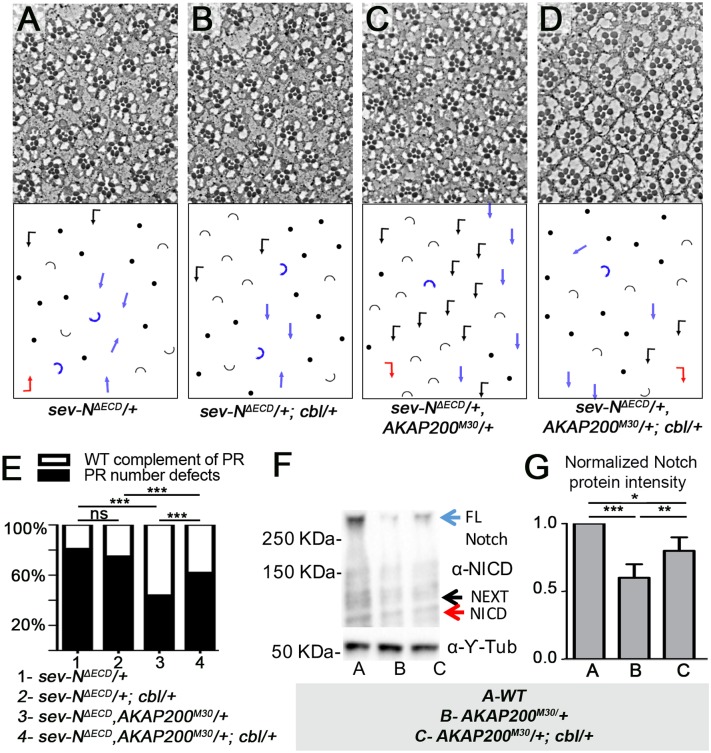
The effect of AKAP200 on Notch signaling depends on Cbl.(A-D) Tangential adult eye sections of indicated genotypes, with schematics in lower panels (see
Fig 2A
for key). (A) PR number defects induced by sev-NΔECD are not modified by the heterozygous cbl mutant alone (B), but are suppressed by heterozygous AKAP200 mutant (C). (D) Simultaneous reduction of one genomic copy of both cbl and AKAP200 reduces the effect of AKAP200 suppression of Notch activation. (E) Quantification of genetic interactions of genotypes in (A-D): ***p<0.0001 from chi square tests (n = 320–686 from 3–4 independent eyes). (F-G) Western blot (F) of third instar larval eye disc lysate showing Notch protein expression (blue arrow: full length Notch, black arrow: membrane bound NEXT, red arrow: NICD). Relative to WT (left lane), a reduction in total endogenous Notch protein is observed in AKAP200M30/+ (middle lane), which is partially suppressed in lysates from AKAP200M30/+; cbl/+ (©-Tub [Y-Tub], bottom, serves as loading control). (G) Quantification of Western blot lanes from (F); n = 3, **p = 0.003, p = 0.01 from student’s t test (error bars represent standard deviations).